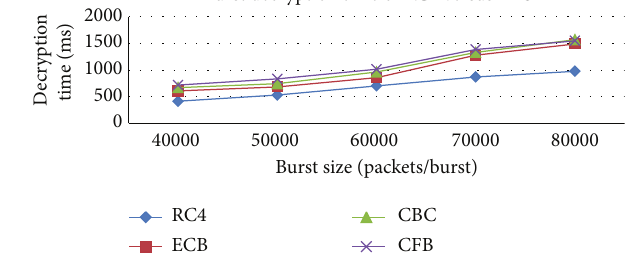
Figure 4: Comparison of burst decryption time with various